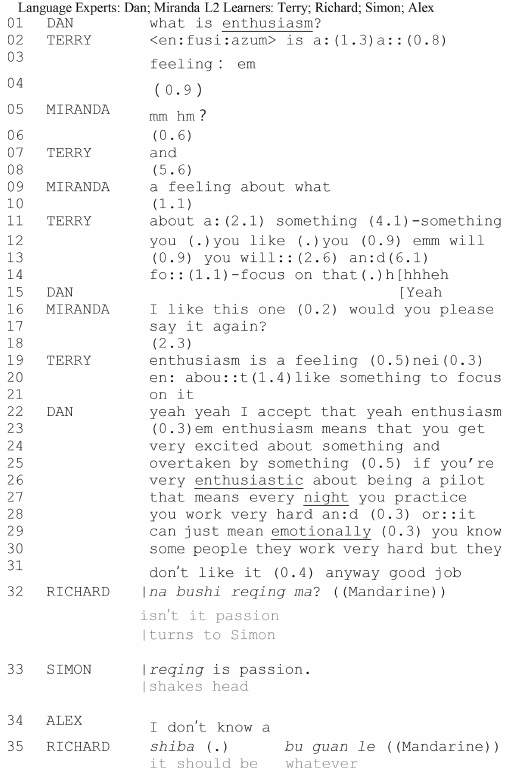
FIGURE 3 Possible individual epistemic change from a less knowing stance to an updated more knowledgeable condition.